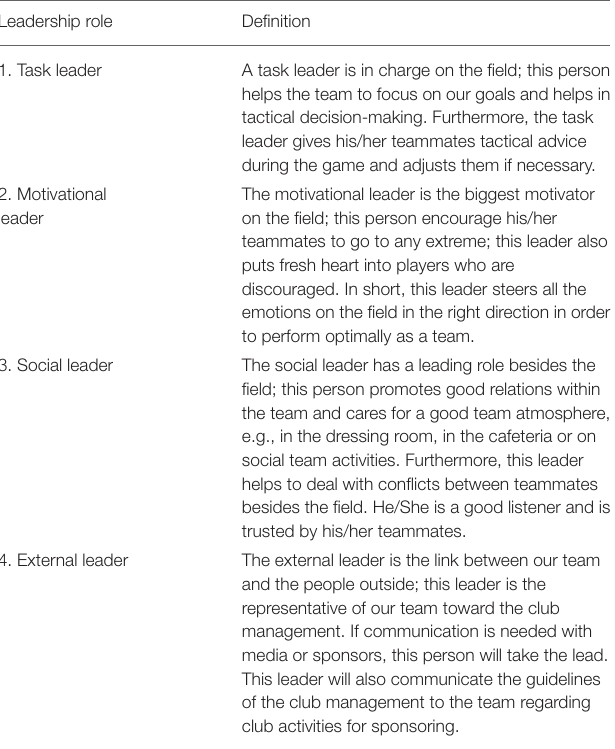
TABLE 1 | The definitions of the four leadership roles, as described by Fransen et al. (2014). Leadership